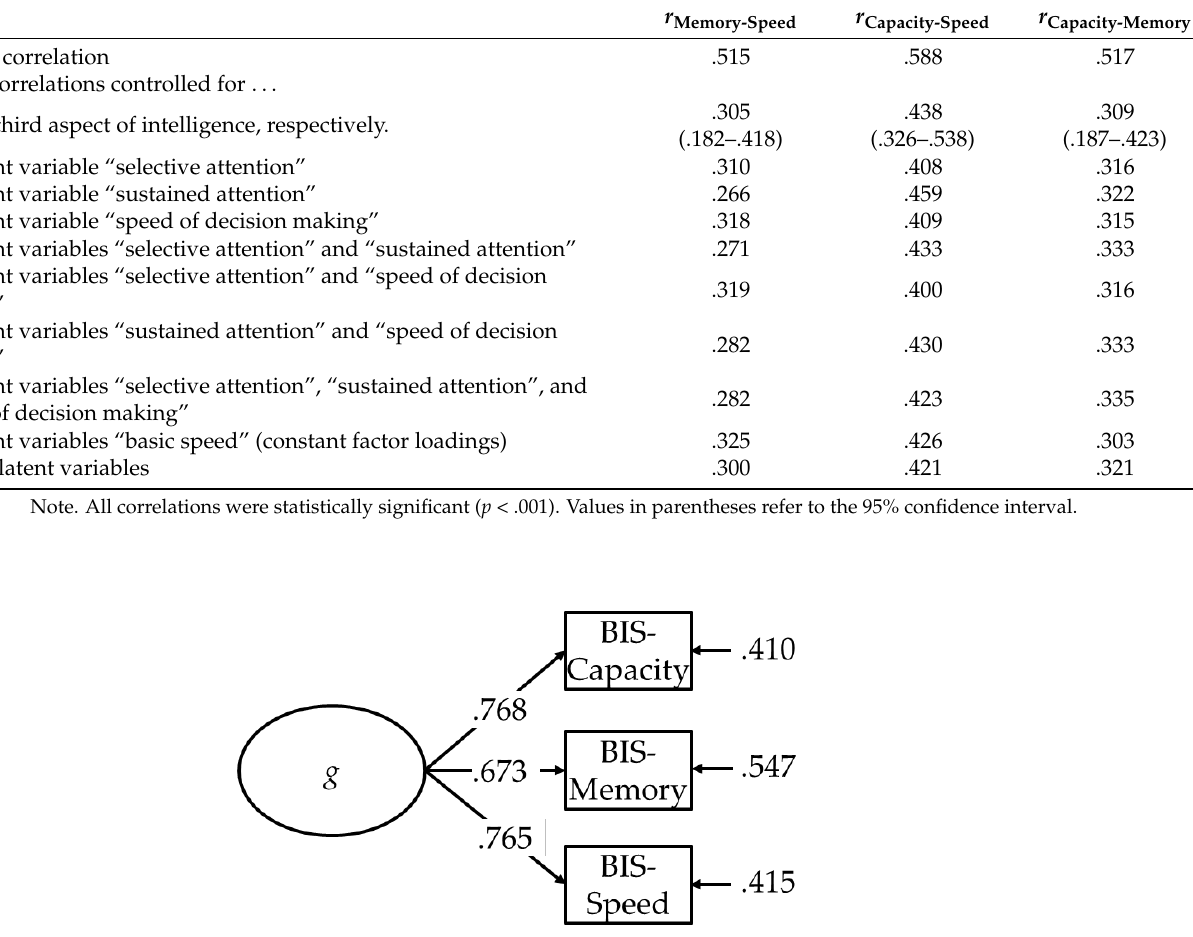
Figure 1. The g factor extracted from the average scores of BIS-Capacity, BIS-Memory, and BIS-Speed tests.